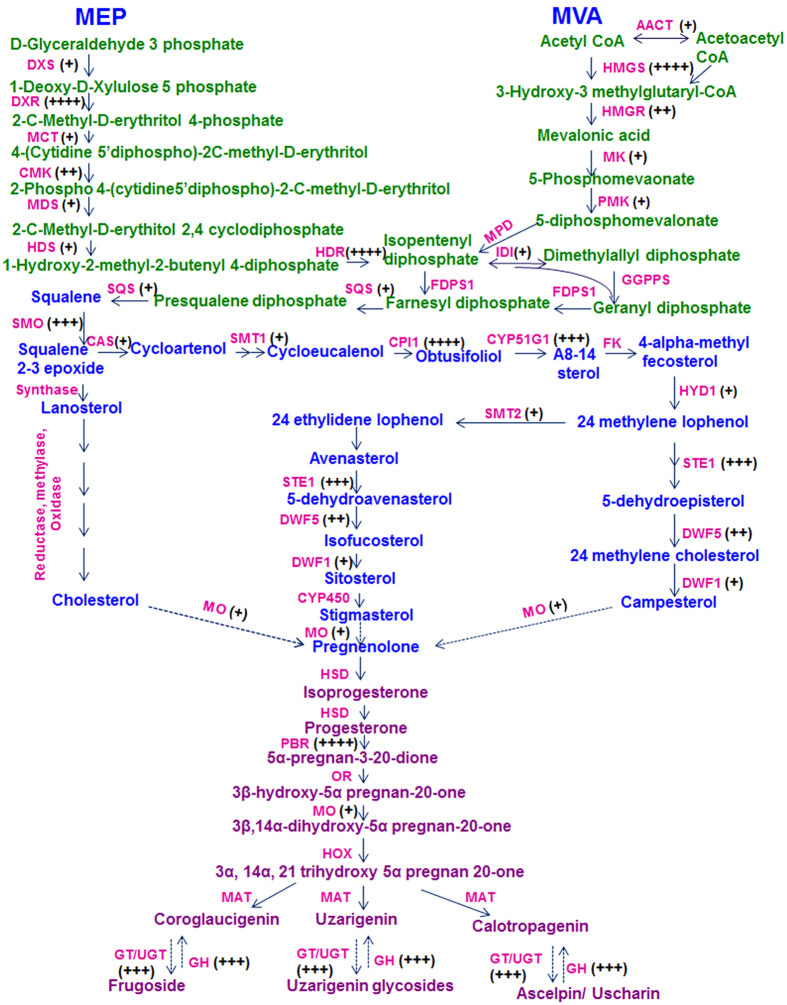
Putative cardenolide biosynthetic in C. procera.The pathway has been divided into three subgroups as terpenoid backbone biosynthesis, steroid biosynthesis and cardenolide biosynthesis. The enzymes with corresponding unigenes are mapped. Fold induction is represented by + sign; 0–2(+), 2–4(++), 4–10(+++), >10(++++) Full names of genes are mentioned in Supplementary Table 4.